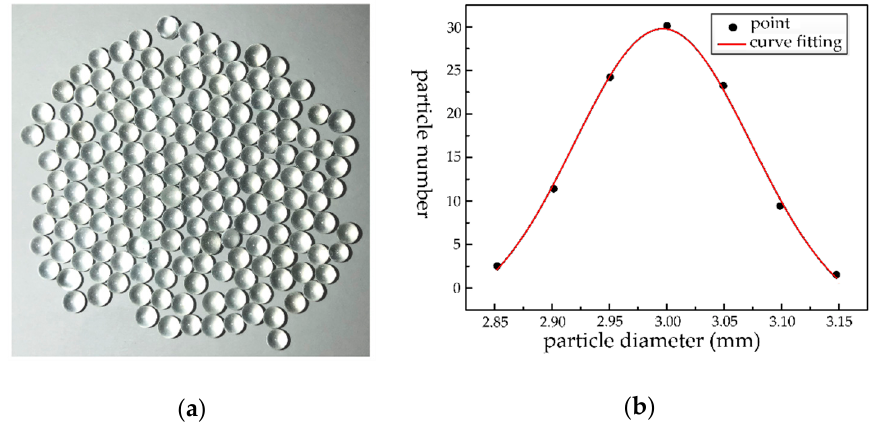
Figure 3. ( a ) Glass particles; ( b ) particle diameters.